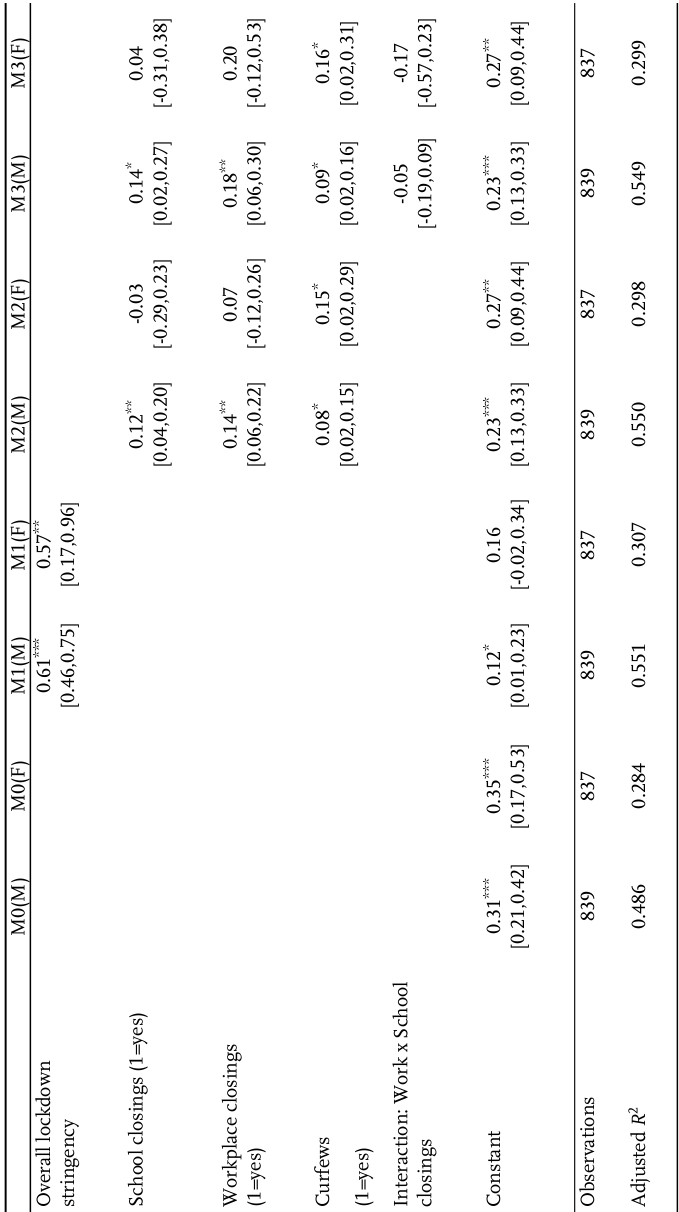
Table 4: Results of 2-way fixed-effects regressions (DV = deviation from the predicted